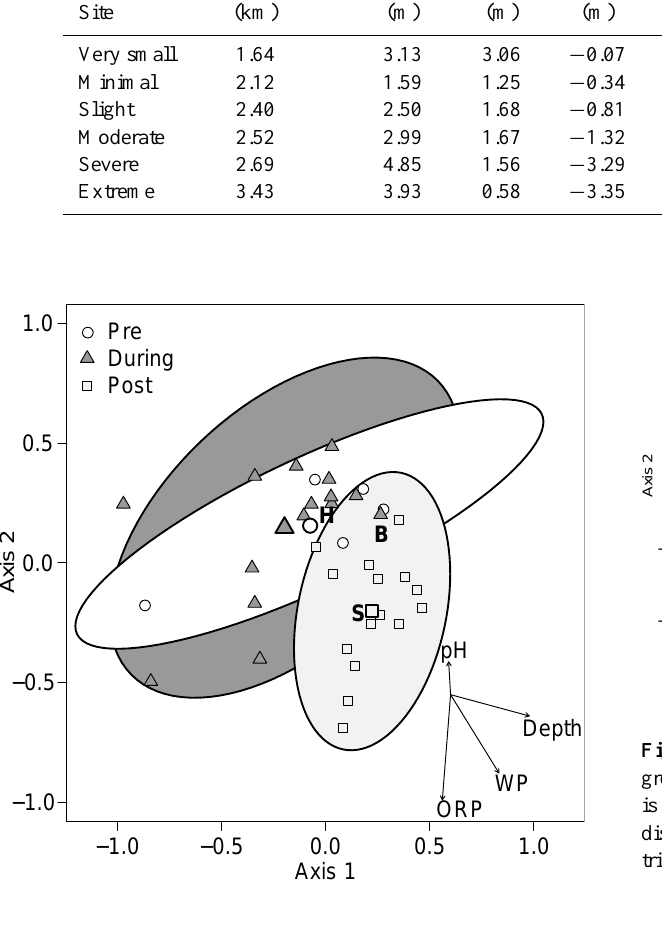
Fig. 2. Macroinvertebrate community NMS ordination joint bi- plot, with groupings by pre-, during-, and post-dewatering. Larger shapes represent group centroids. Letters represent taxa group lo- cations on the biplot, “H” = hydrophyte-associated, “B” = benthic, and “S” = swimming. The joint plot on the bottom right indicates the direction and magnitude of the primary environmental gradients (WP = wetted perimeter). These 2 NMS axes capture 64.15 and 17.79% of the variation in the data, respectively. Ellipses are 95% confidence intervals.